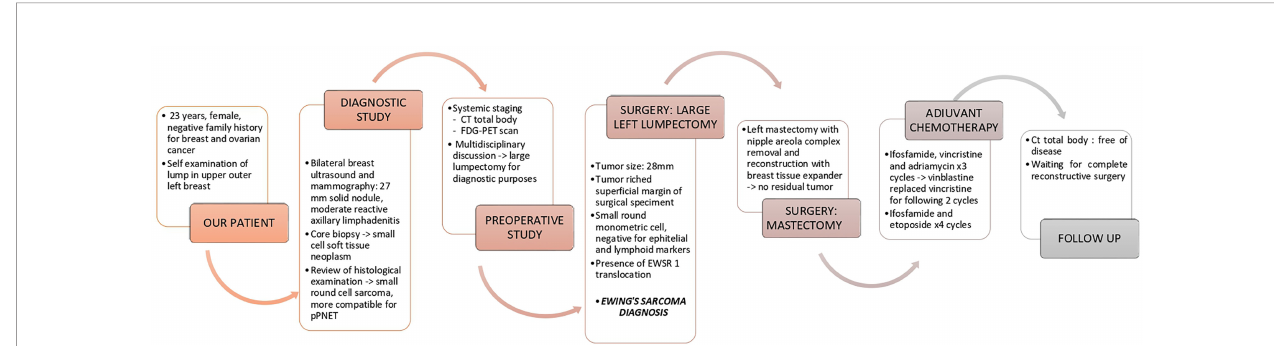
FIGURE 4 | Temporal timeline.